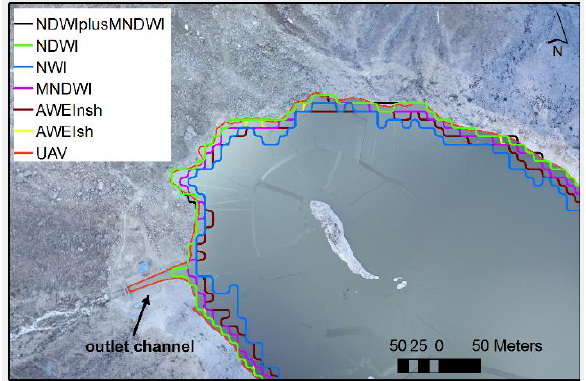
Figure 3. Water indices at the outlet of the Tsho Rolpa Glacial Lake on 18-05-2019, superimposed over the UAV-constructed orthomosaic.